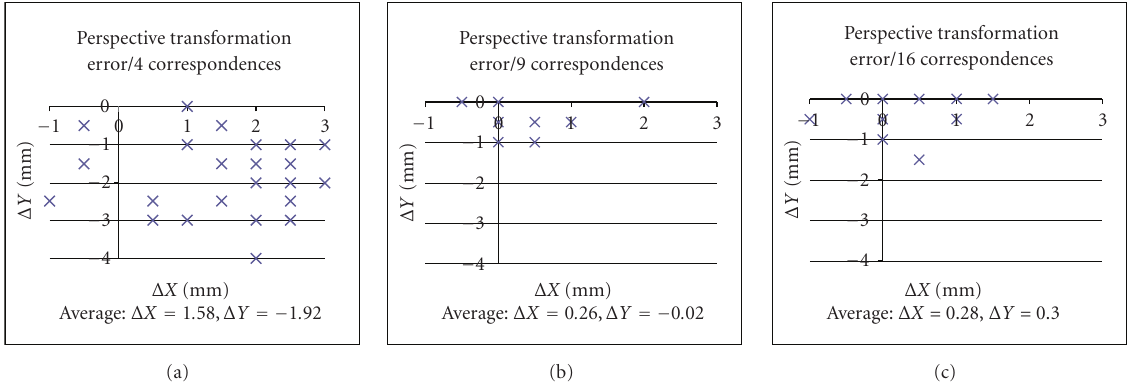
Figure 12: Geometric error of perspective transformation on an actual surface (world coordinates) using the number of calibrated correspondences of 4, 9, and 16.